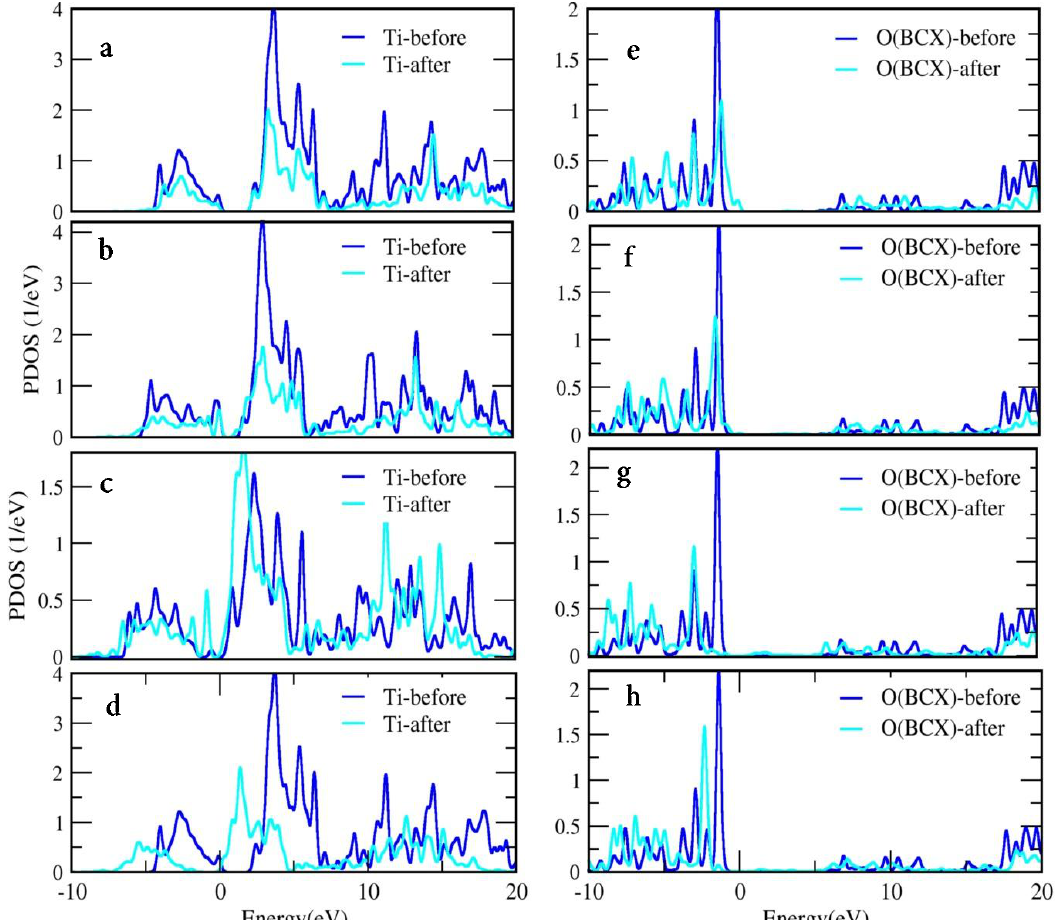
Fig. 5. PDOS for the adsorption of IMMUCILLIN-A molecule on the N-doped nanoparticles before and after the adsorption process, (a, e) Configuration A; (b, f) Configuration B; (c, g) Configuration C; (d, h) Configuration